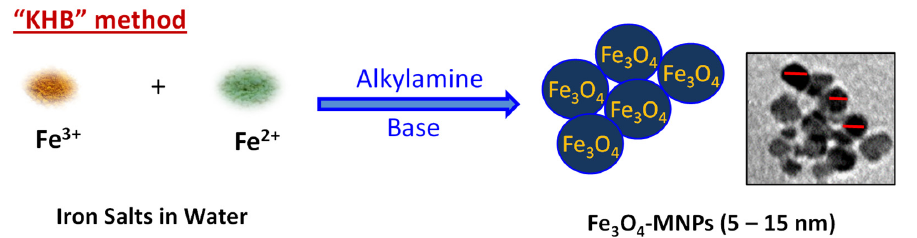
Figure 1. Schematic representation for the synthesis of iron oxide magnetic nanoparticles (Fe 3 O 4 -MNPs) using Ko-precipitation Hydrolytic Basic (KHB) methodology.